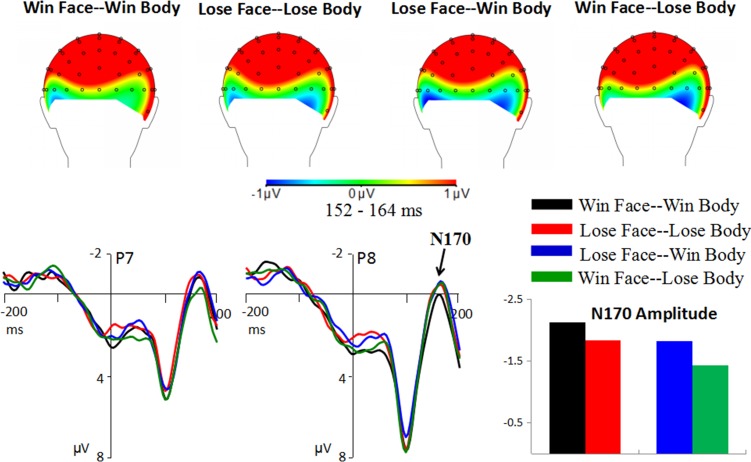
Grand average of the N170.